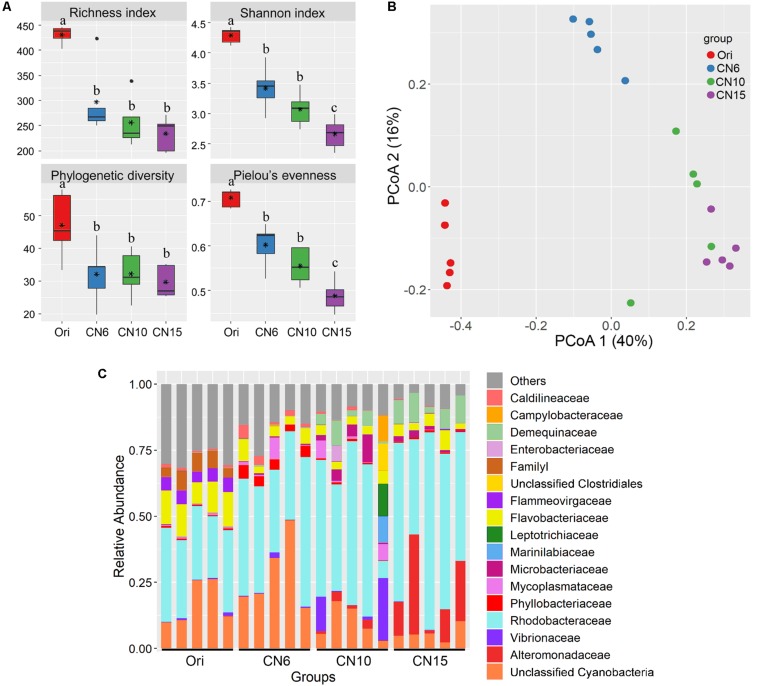
(A) Differences in intestinal microbial α-diversity indexes among the four groups. Different lowercase letters on the histogram indicate significant difference (one-way ANOVA, P < 0.05); (B) Principal coordinate analysis (PCoA) visualized the differences of intestinal microbial community structure among different groups; (C) Relative abundances of the dominant bacterial families (relative abundance >5%) in the shrimp intestines.